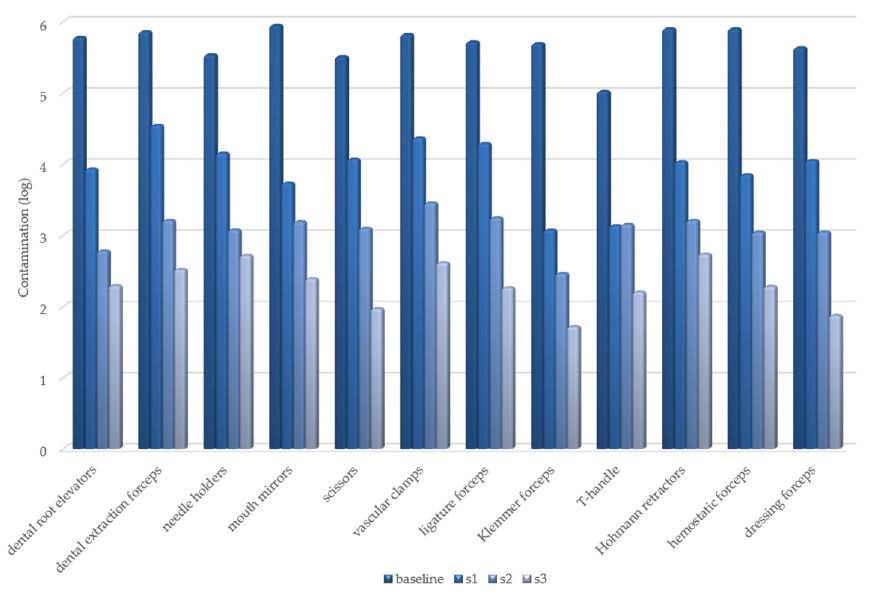
Figure 2. Test point 2: variation in degree of contamination in each cleaning